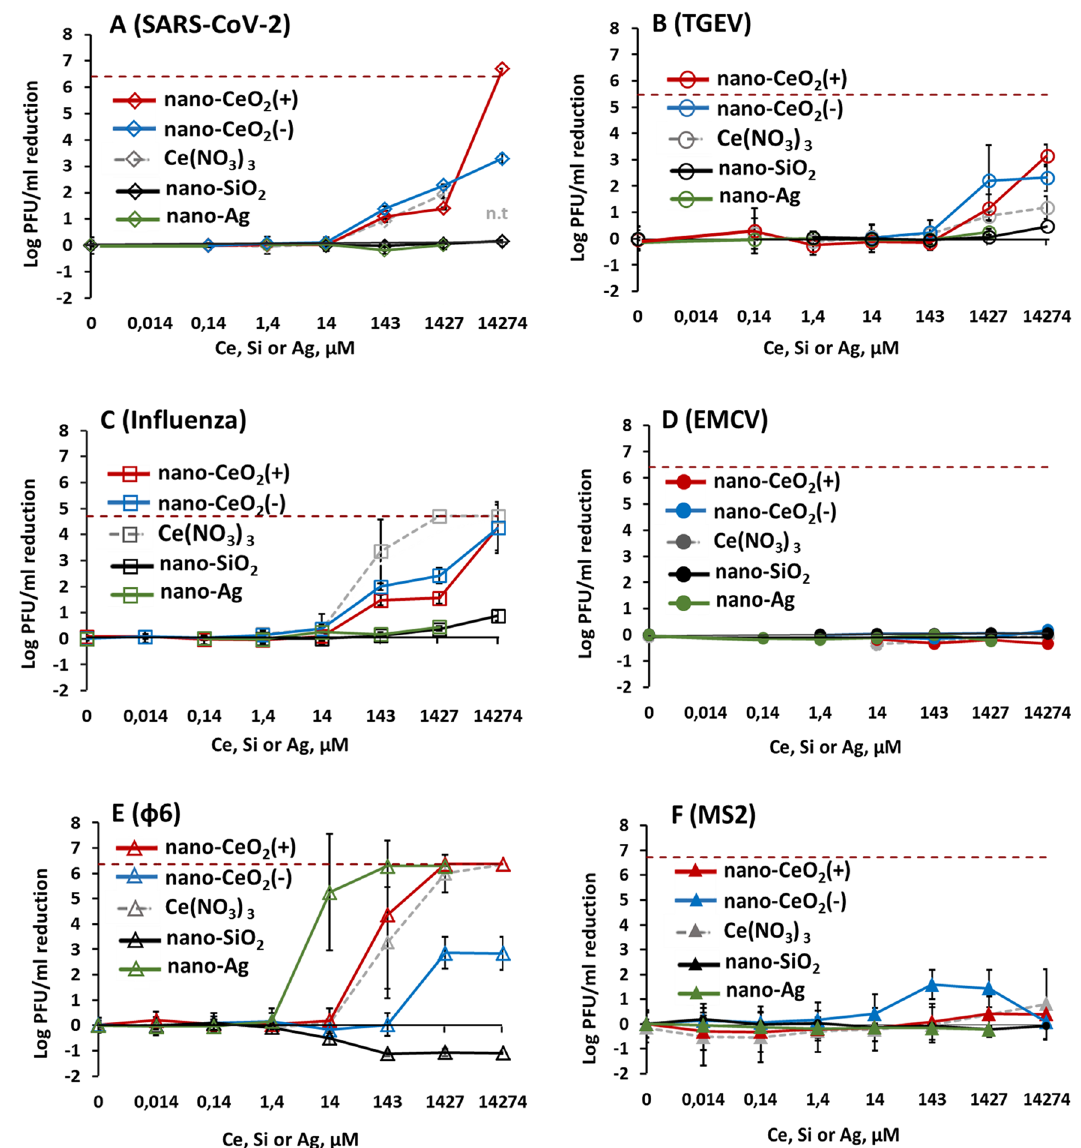
Figure 4. Antiviral activity of all tested nanoparticles and chemical compounds expressed in µM concentrations to enable comparison. Please note that antiviral activity is expressed as reduction of infectious viral titer, logPFU per ml compared to unexposed control after 1 h. The data of nano-CeO 2 are transferred from Fig. 3. ( A ) coronavirus SARS-CoV-2; (B) transmissible gastroenteritis virus TGEV; ( C ) influenza virus A/ WSN/1933; ( D ) picornavirus EMCV; ( E ) bacteriophage ф6; ( F ) bacteriophage MS2. Closed symbols in ( D,F ) represent non-enveloped viruses. The results of three independent experiments with standard deviation are shown. Note the logarithmic scale of y-axis. Horizontal dark red dashed line shows the limit of quantification of PFU reduction